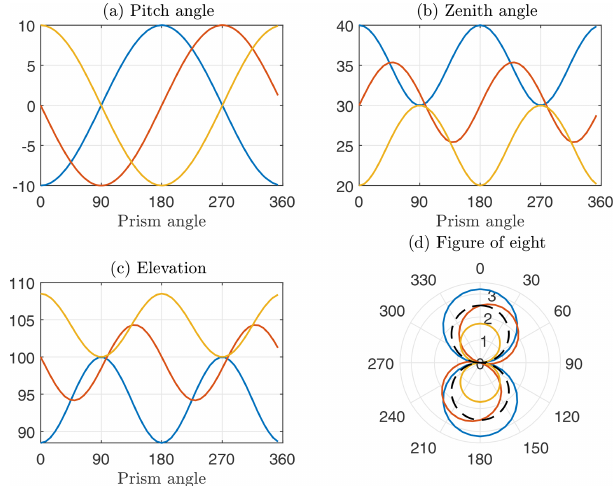
Figure 5. ( a ) Relative motion-induced measurement error caused3 by pitch motion with oscillation frequency f p = f s = 1Hz and am- plitude A = 10 ◦ as a function of phase offset between lidar prism angle and motion (dot markers). Colored vertical lines mark three particular cases as in Figs. 3–4. Small non-zero bias marked by dashed horizontal line. ( b ) Histogram showing the distribution of positive and negative wind speed